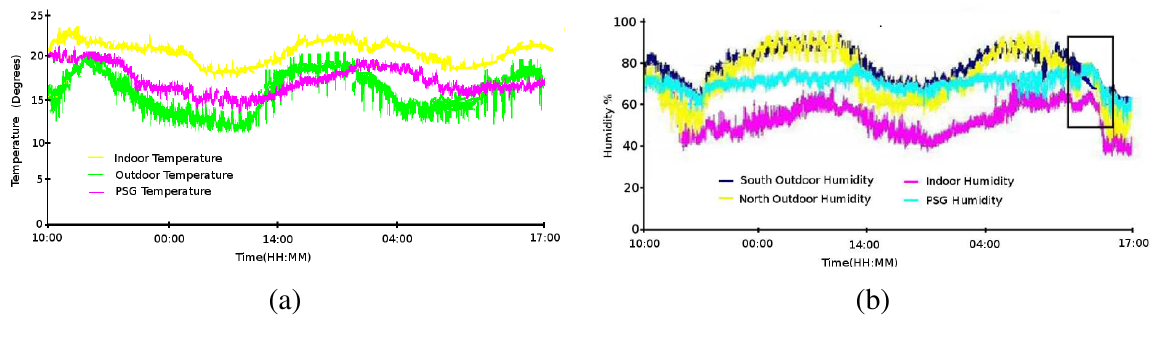
Figure 11. (a) Temperature and (b) humidity measurements for the first experiment period.